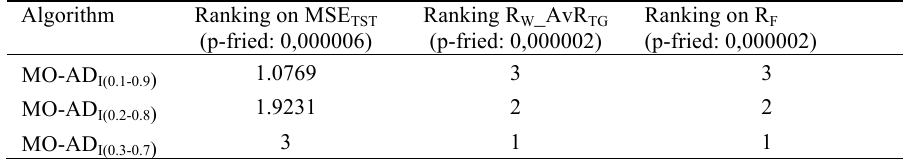
Table A.6 Rankings obtained through Friedman’s test for different values of thresholds on MSE TST , R W _AvR TG and #R F measures using FS_MOGUL rule bases MEDIAN INT/ACC point.